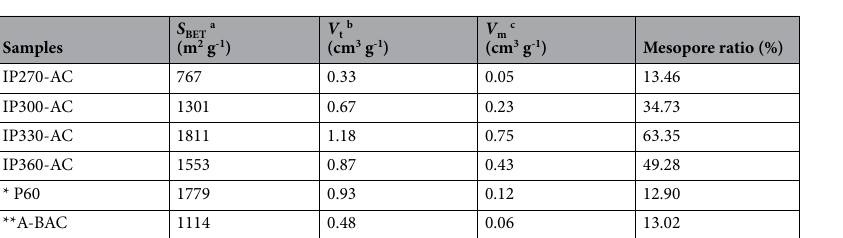
Table 3. Comparison of physical properties of activated carbon prepared by steam activation of the surface oxidized pitch at various oxidation temperatures. a S BET : Specific surface area calculated by the Brunauer– Emmett–Teller (BET) method ( P/P 0 = 0.05–0.15). b V t : total pore volume. c V m : mesopore volume. *P60: Commercial activated carbon (Kuraray, Japan). **A-BAC: Commercial activated carbon (Kureha,